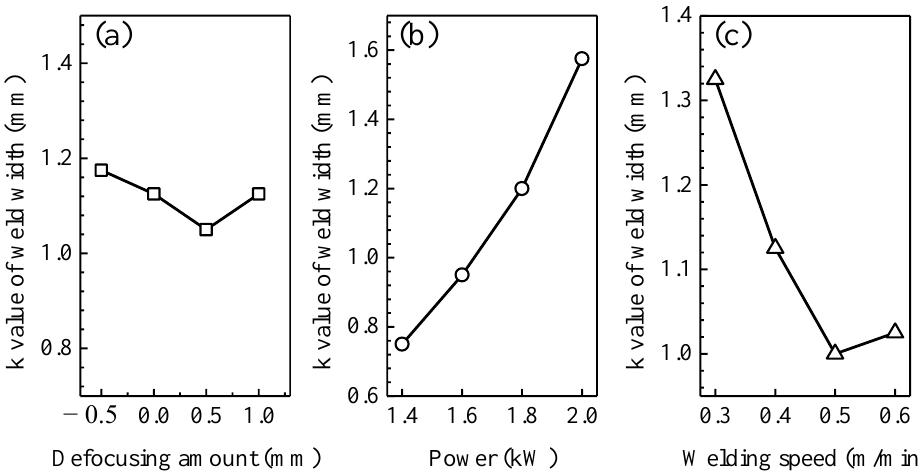
Figure 4. Relationships of ( a ) the defocusing amount, ( b ) power, and ( c ) welding speed with the weld width of Mo – Re joints with a thickness of 2 mm.